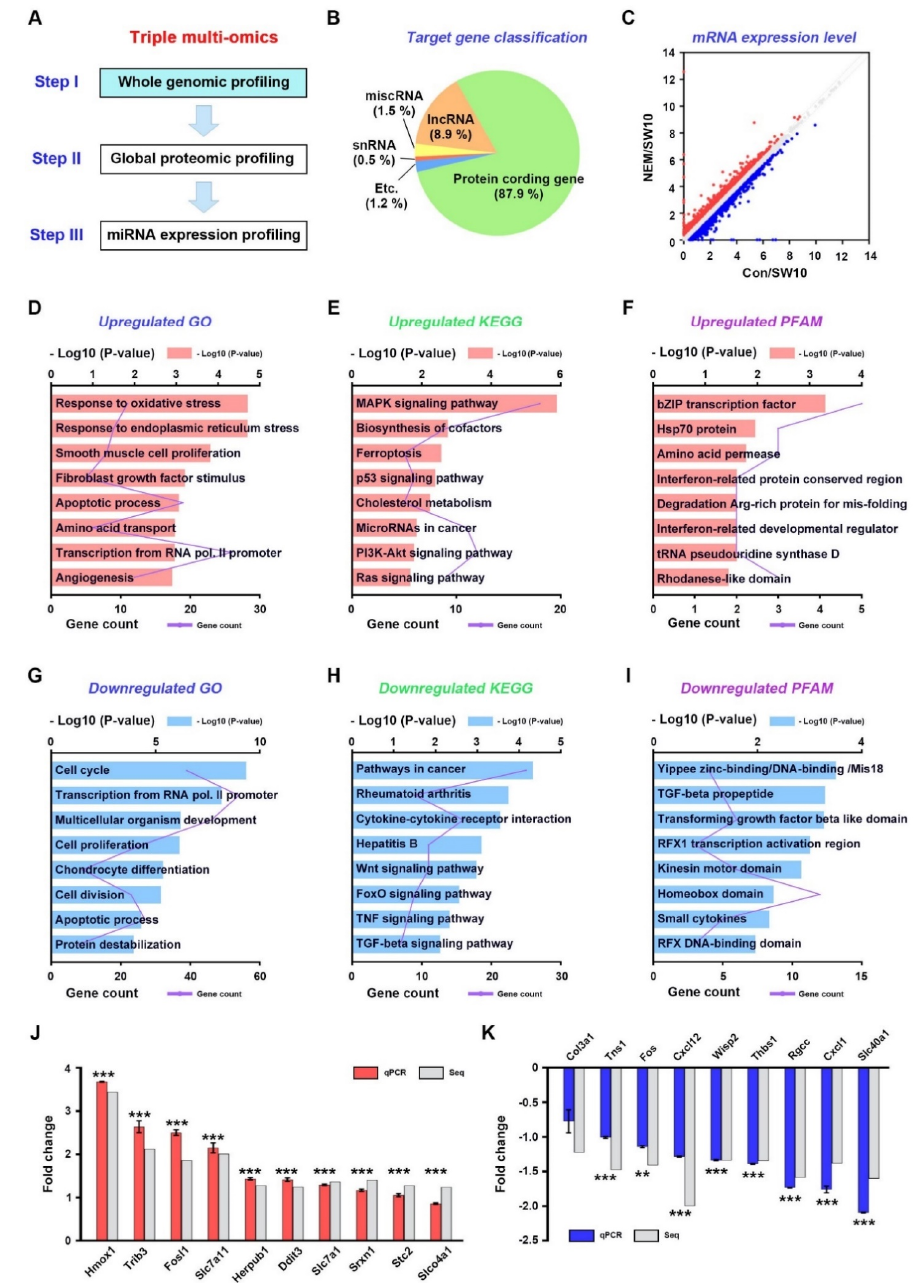
Figure 1. Whole genomic analysis with NEM as an inhibitor for hydrogen sulfide pathway using SW10 cells. ( A ) The first stage of a three-stage framework for integrating triple multi-omics data. The SW10 cell culture was performed for 5 h after NEM treatment. ( B ) The pie chart represents detected genes into five summarized transcript types. ( C ) A scatter plot of pairwise expressed genes. X -axis and y -axis present log2 value of normalized gene expression. Red, blue, and gray dots refer to upregulated, downregulated, and nonregulation genes. GO terms ( D ), KEGG pathways ( E ), and PFAM ( F ) enrichments of upregulated genes are shown. GO terms ( G ), KEGG pathways ( H ), and PFAM ( I ) enrichments of downregulated genes are shown. qPCR validation of the RNA-sequencing (Seq) in the upregulated ( J ) and downregulated ( K ) top 10 genes. Seq, RNA sequencing. Comparisons were performed using a Student’s t -test. ** p < 0.01 and *** p <